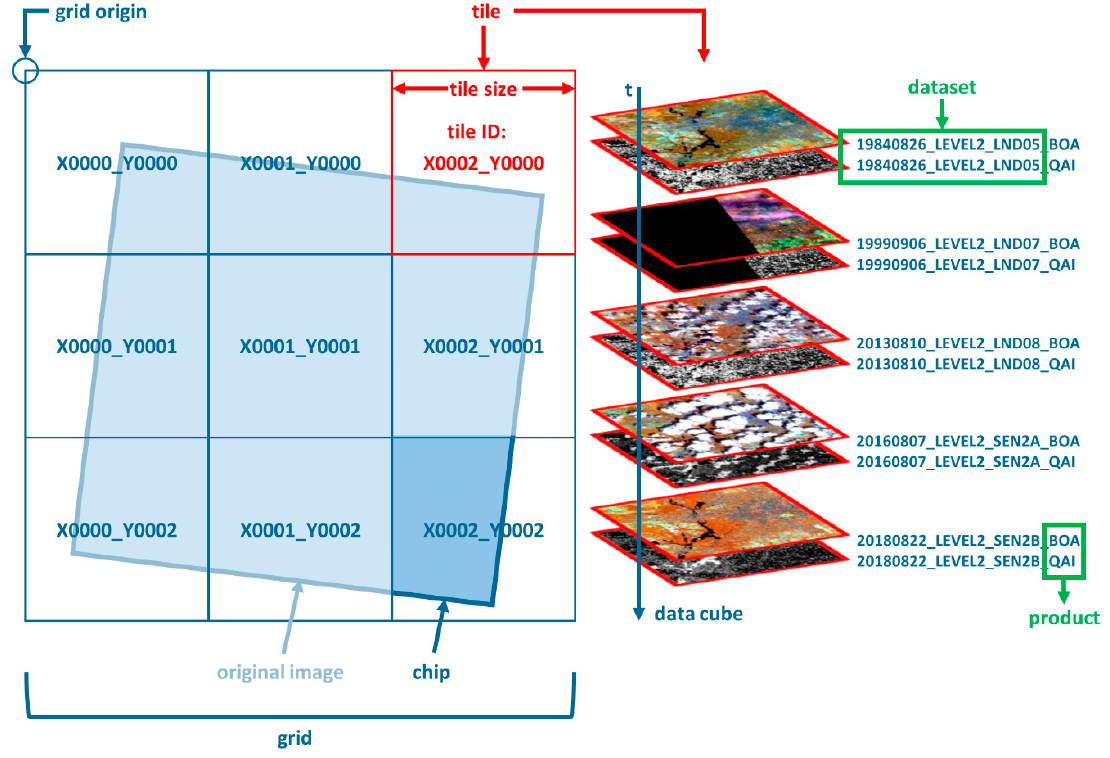
Figure 1. Overview of gridding and data cube terminology used in FORCE (Framework for Operational Radiometric Correction for Environmental monitoring).